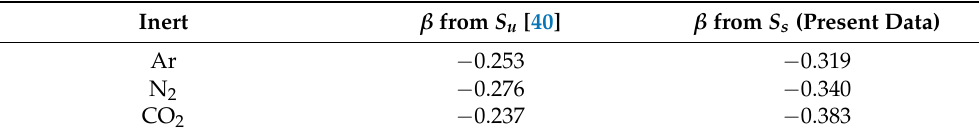
Table 4. Baric coefficients from LBVs and from PVs, at initial ambient temperature. Inert β from S u [40] β from S s (Present Data) Ar − 0.253 − 0.319 N 2 − 0.276 − 0.340 CO 2 − 0.237 − 0.383